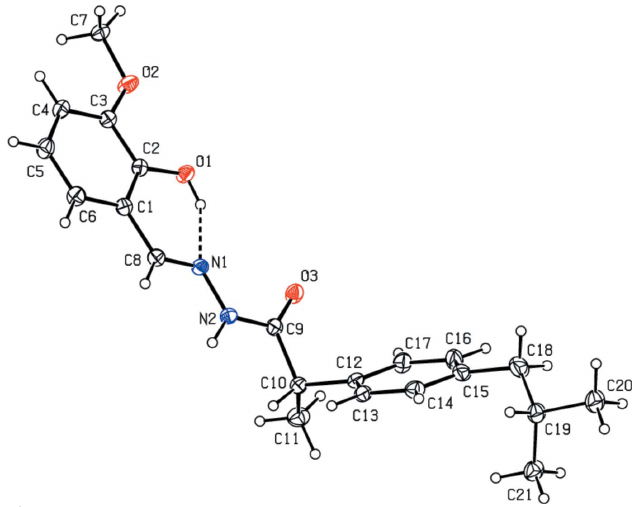
Figure 1 The title molecule with labeling scheme and 30% probability level ellipsoids. The intramolecular O—H (cid:3)(cid:3)(cid:3) N hydrogen bond is depicted by a dashed line. Only the major component of the disorder is shown.